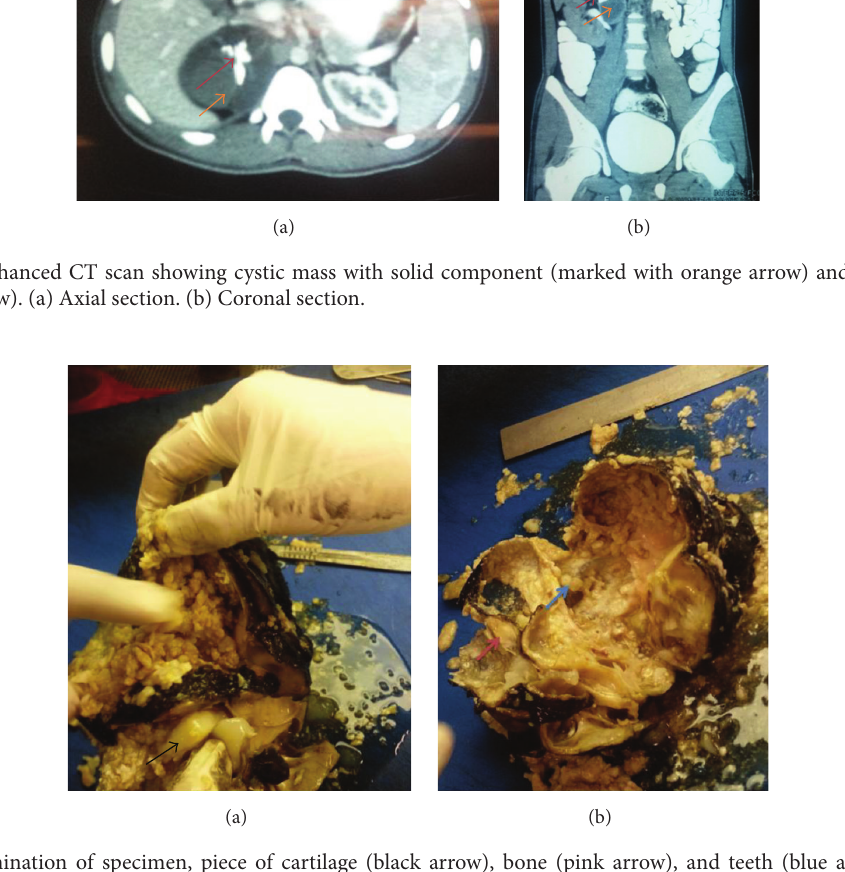
Figure 2: Gross examination of specimen, piece of cartilage (black arrow), bone (pink arrow), and teeth (blue arrow) with mucinous